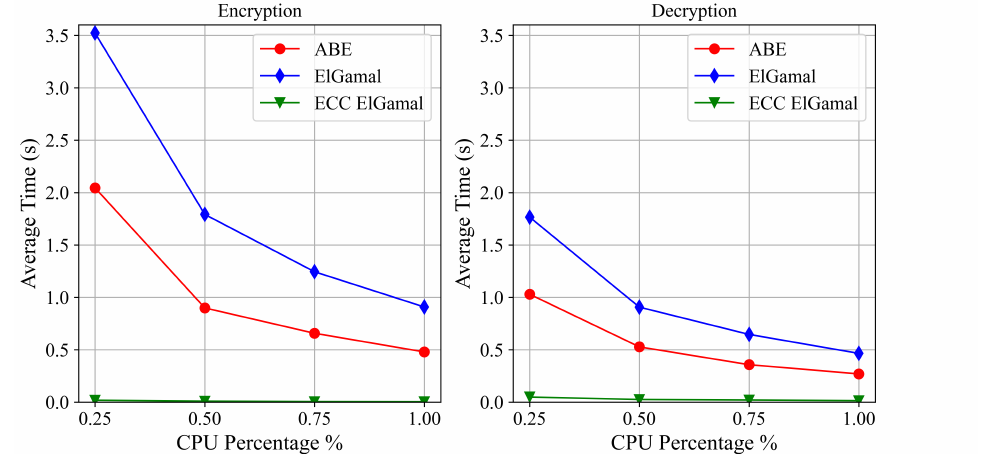
Figure 10. Raspberry Pi 3 B+